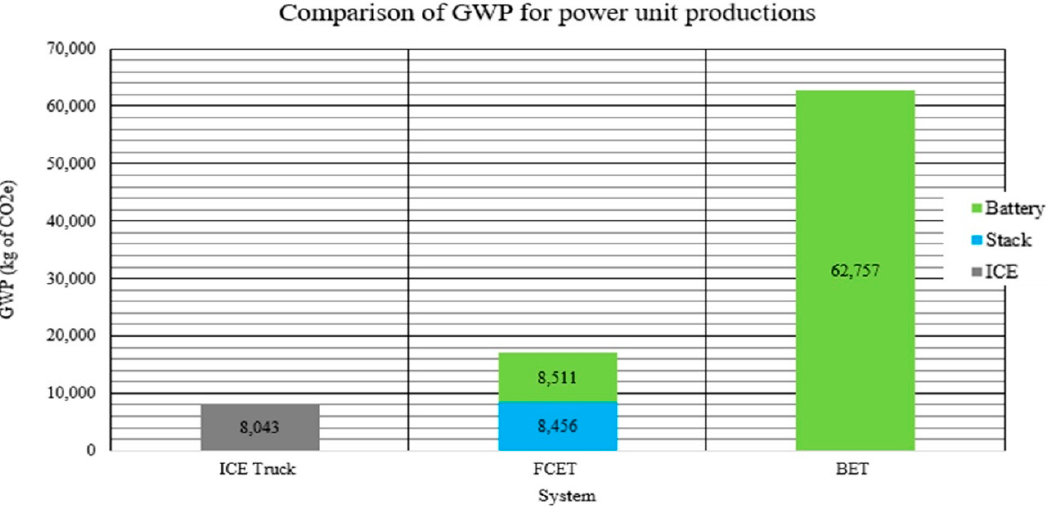
Figure 3. Comparison of GWP per System.